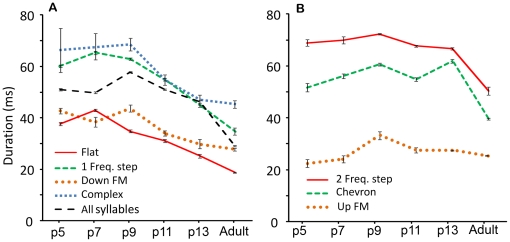
Developmental changes in syllable duration.The means and standard errors of the durations are shown. (A) These syllables showed a progressive decrease in duration over development. The average durations across all syllables (dashed black line) reflect the pattern of these individual syllable types. (B) These syllables had more complex patterns of duration change across age. Age-dependent durations of the short syllable are not shown, as the criterion for classifying it was duration dependent.